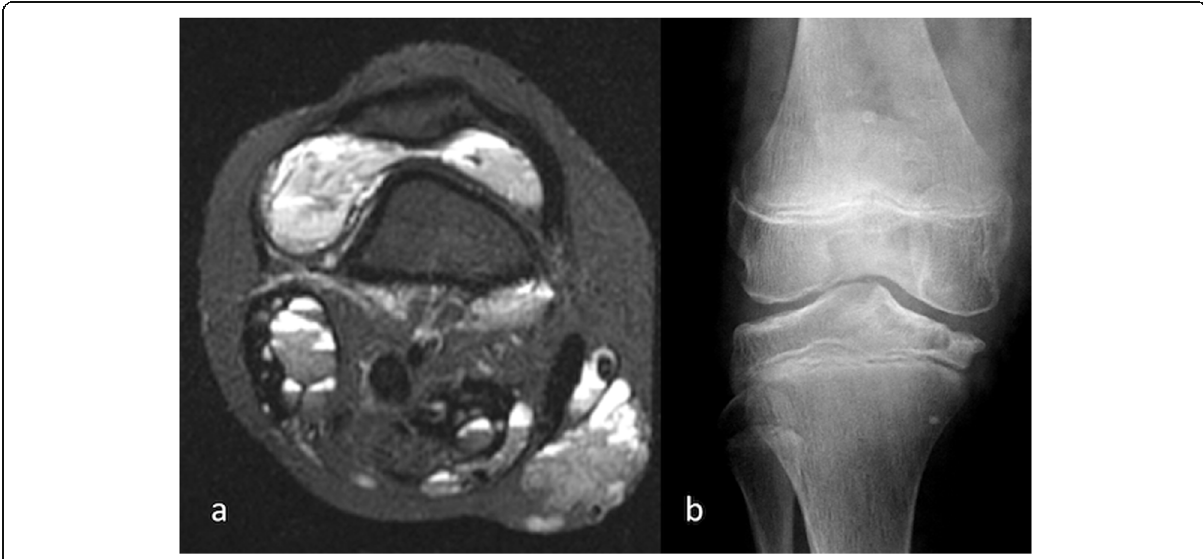
Fig. 5 Venous malformation (VM) of the knee in a 10 year old female. a Axial T2 weighted MR image shows VM within the soft tissues around the knee and within the knee joint itself; b AP radiograph confirms severe articular damage to the knee joint. Soft tissue thickening